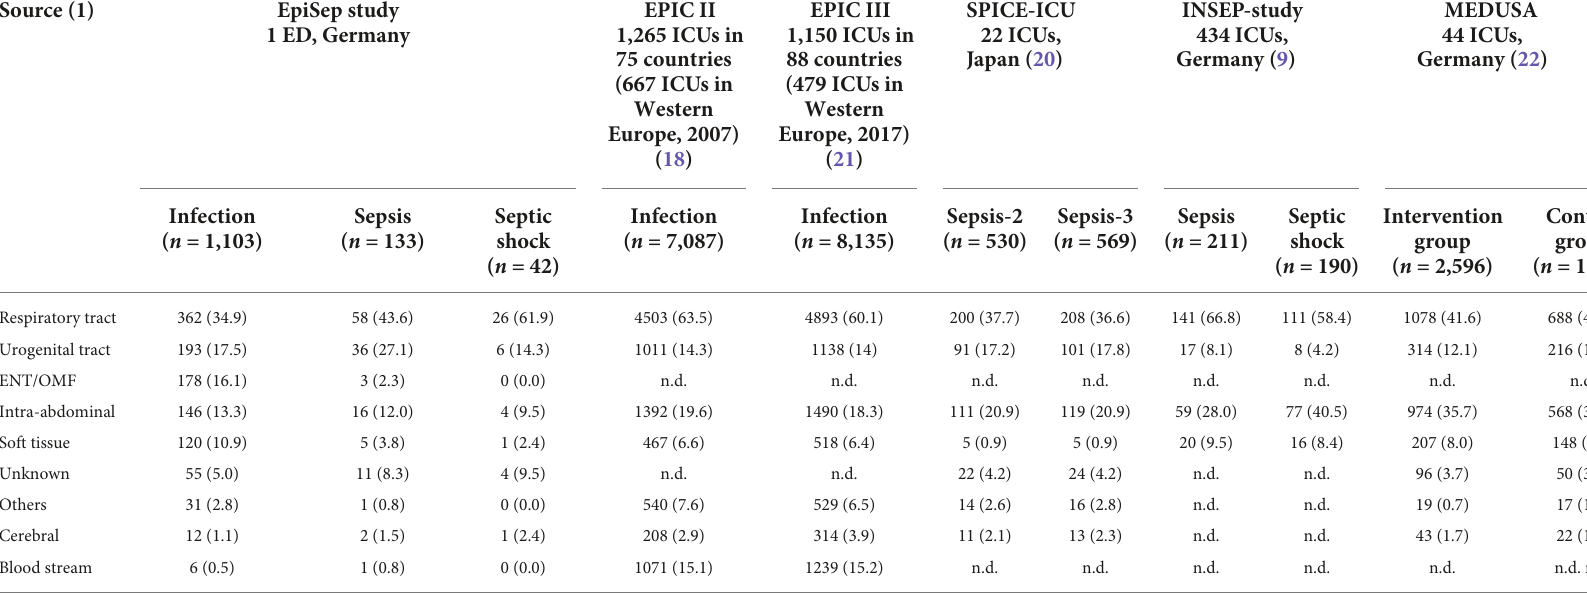
TABLE 4 Comparison of EpiSEP with intensive care unit-studies on epidemiology and causes of infection, sepsis, and septic shock. Source